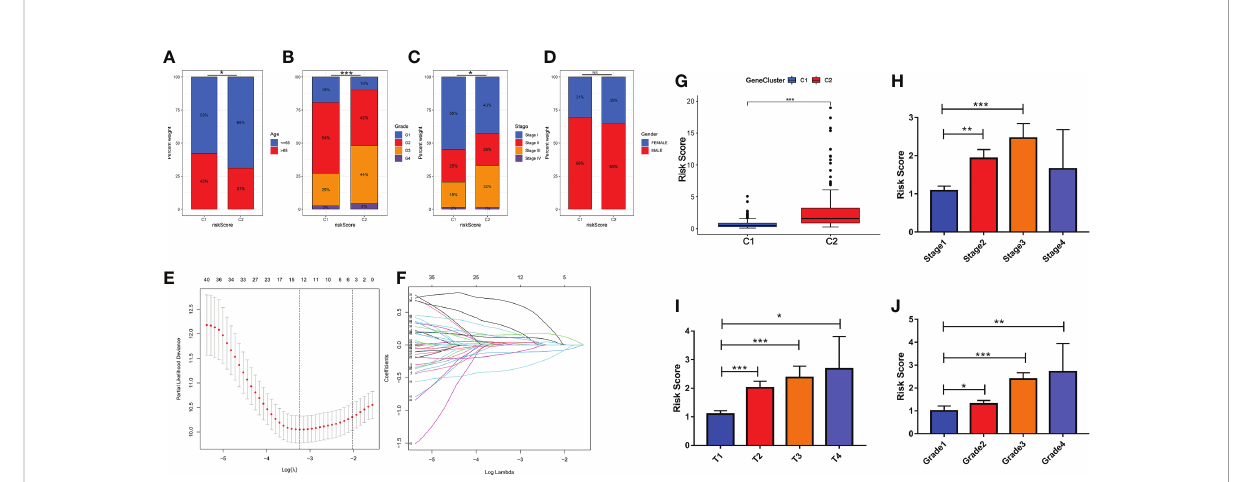
FIGURE 3 Clinical characteristics in patients with hepatic carcinoma based on cluster analysis. (A – D) Analysis of the constituent ratio of clinical characteristics in the two subtypes. (E, F) Lasso regression dimensionality reduction on subtype classi fi cation results. (H – J) Risk scores and pathological characteristics of subtype classi fi cation. *P<0.05, **P<0.01, ***P<0.001. NS: Not Signi fi cant. G: Grade; T: size of the tumor; Stage: tumor progression stage; Grade: grade of tumor pathological